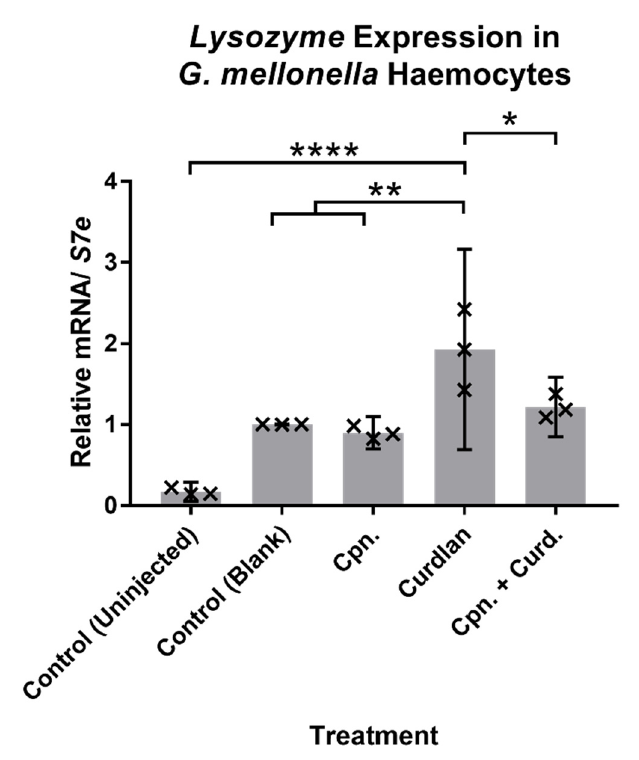
Figure 7. Lysozyme expression in Galleria mellonella haemocytes following injection by curdlan, with or without cordycepin treatment. Curdlan = curd; cordycepin = cpn. Expression levels are relative to the control gene S7e . Error bars show 95% confidence intervals, and labels show differences between means as calculated using t-test, with Bonferroni corrections. * p < 0.05; ** p < 0.01; **** p < 0.0001. Three biological replicates, with each point representing an average from three technical replicates are shown.